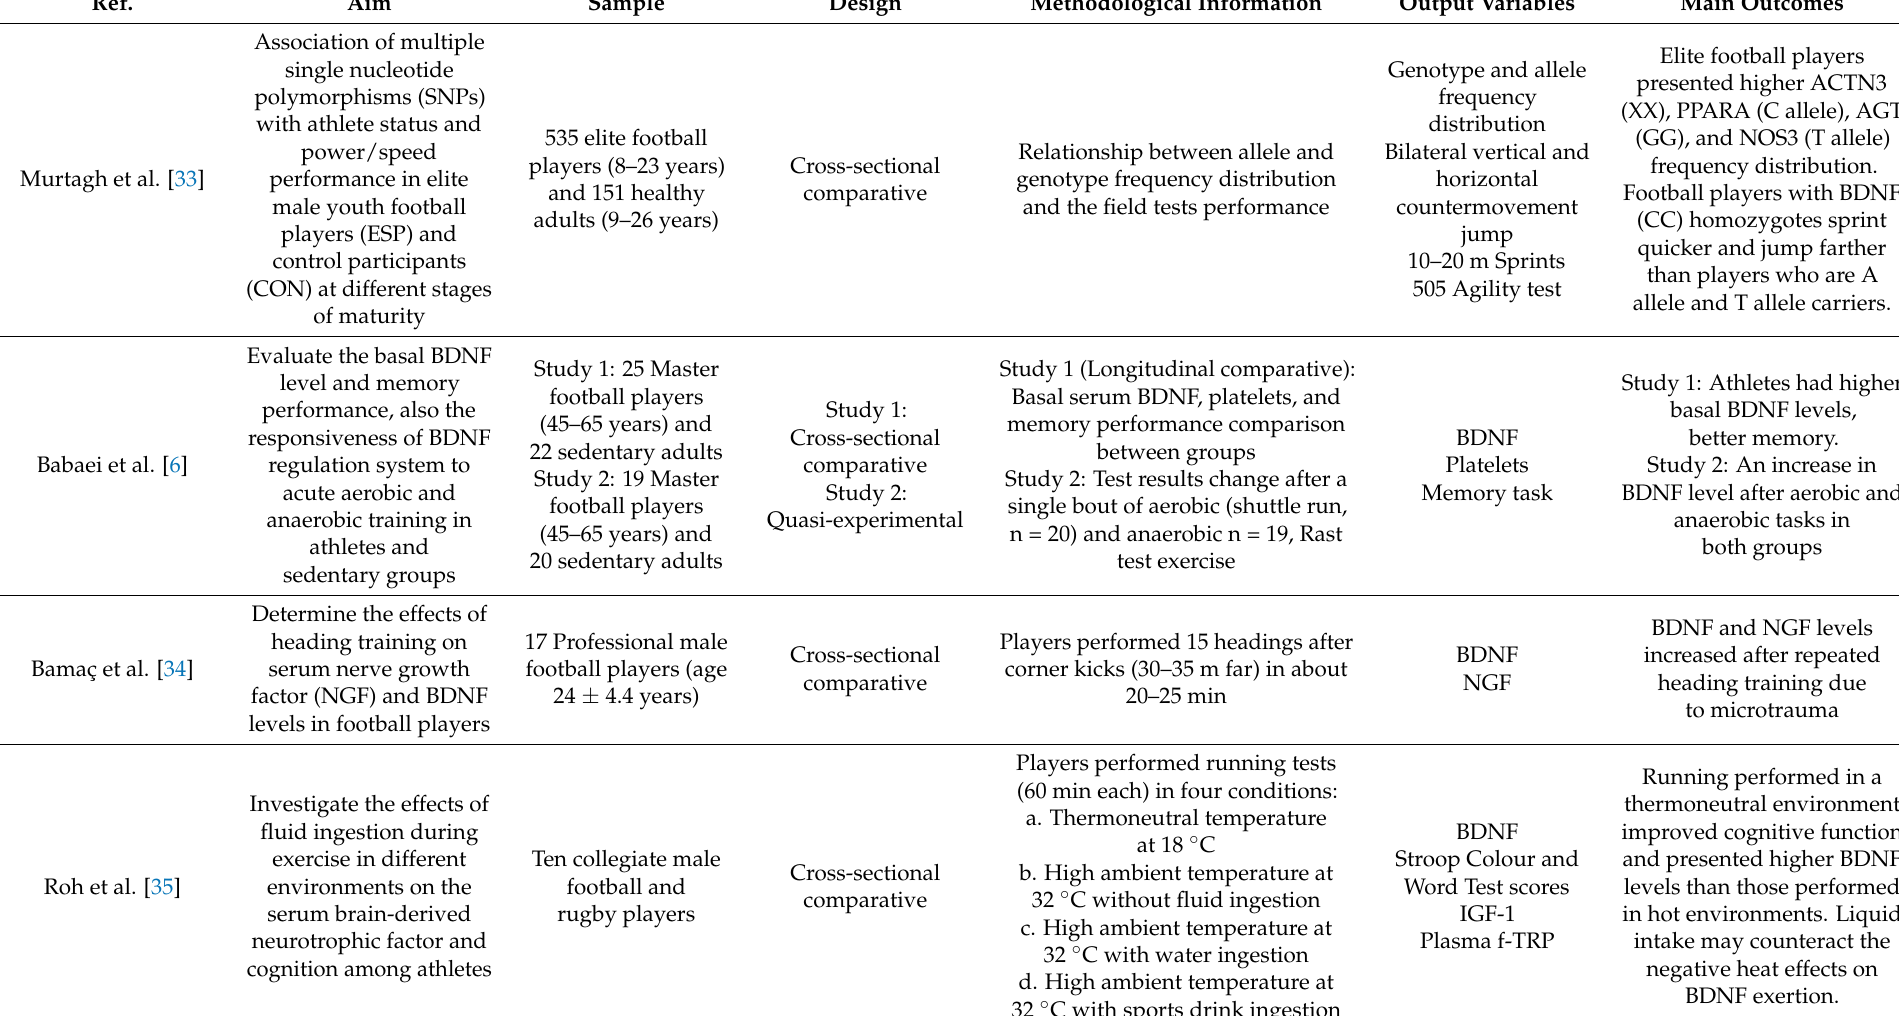
Table 3. Characteristics of studies based on sample, design, and